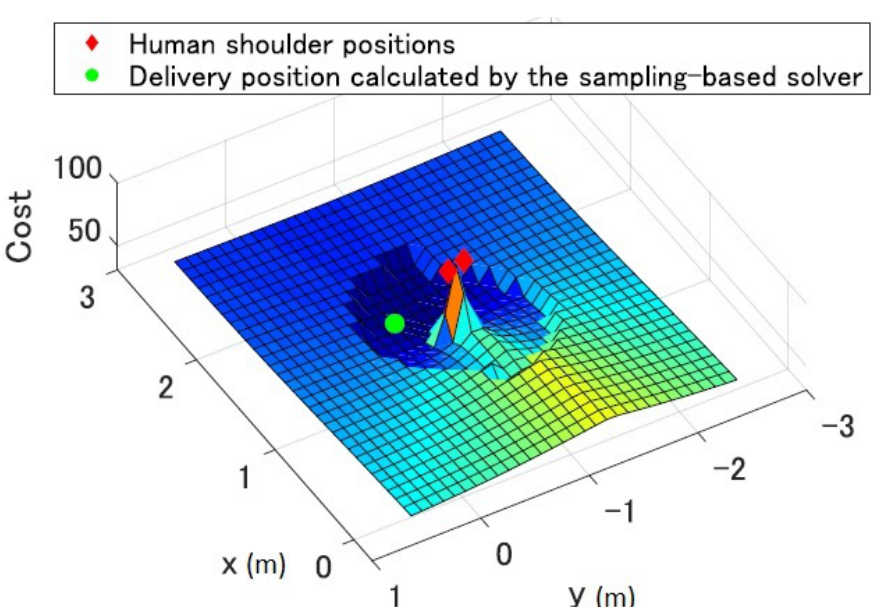
Figure 2. Example of the cost map calculated from the HRI constraints and its optimal delivery